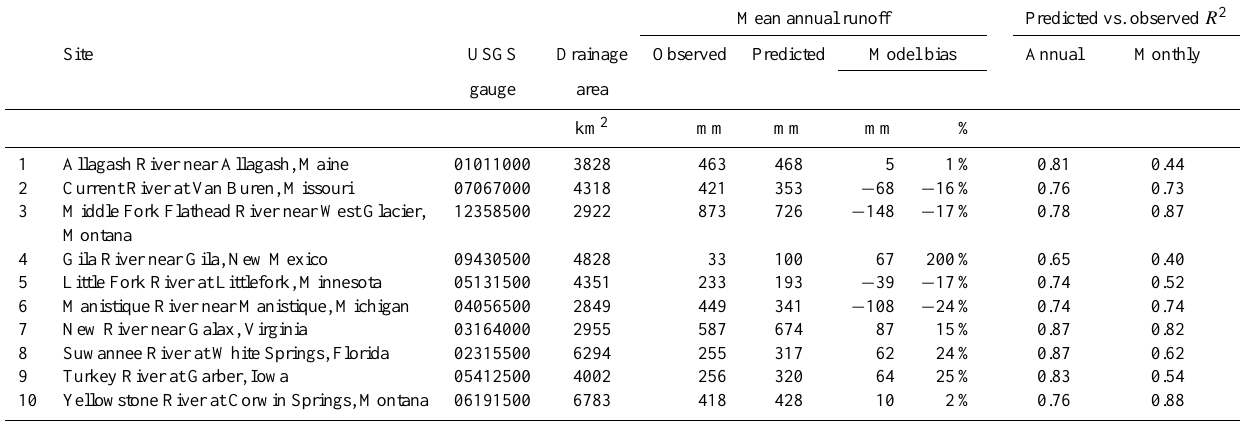
Table 3. Model validation results for 10 representative watersheds 1961–2007.